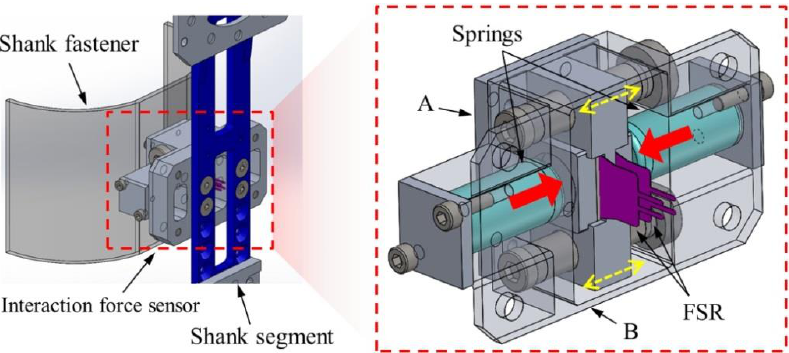
Figure 8. Custom-made sensor for measuring the interaction forces on the thigh and shank segments.